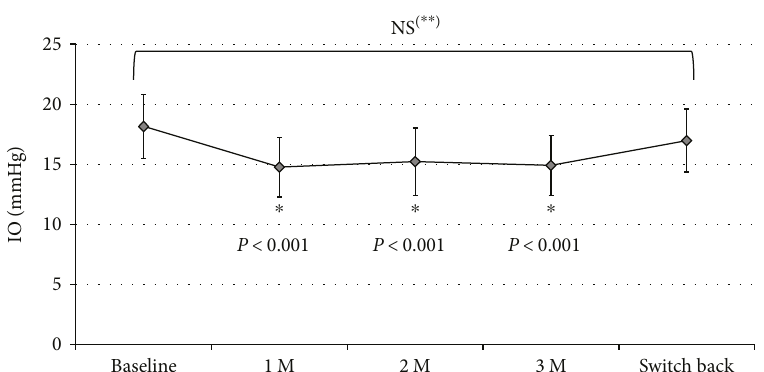
Figure 2: Changes in IOP during the study period. ∗ versus baseline or switch back, repeated measures ANOVA; ∗∗ baseline versus switch back, Student ’ s t -test; bars: SD; M: months; IOP: intraocular pressure.